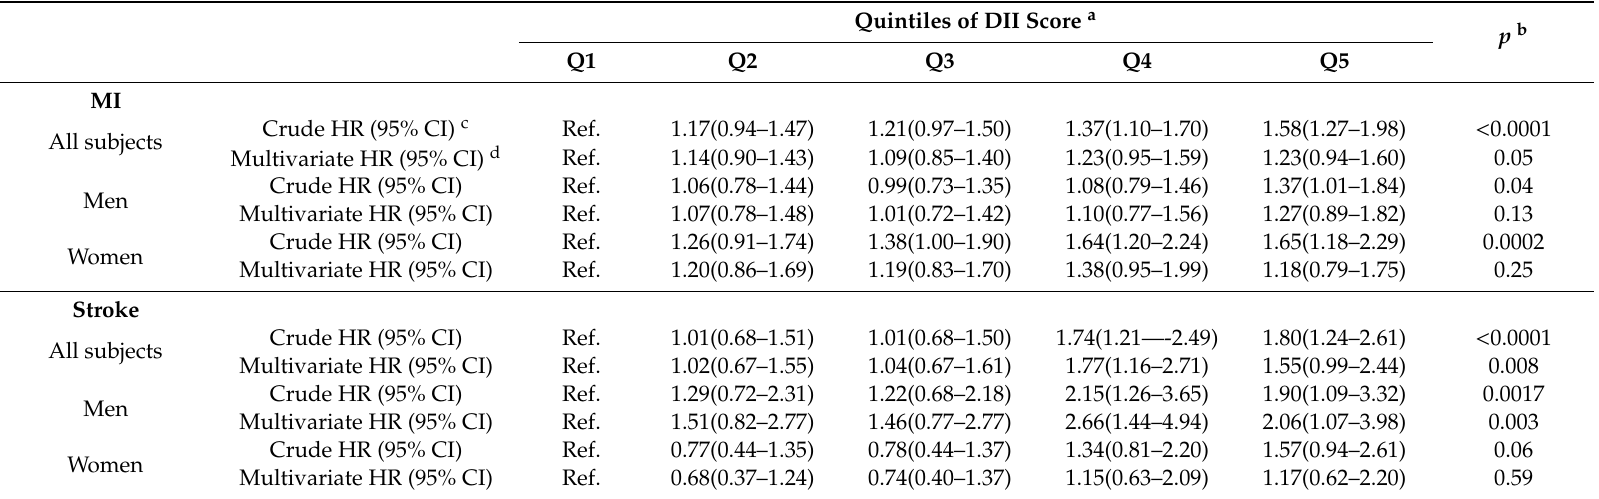
Table 3. Cox proportional hazard ratios (HRs) (95% Confidence Intervals (CIs) for myocardial infarction (MI) and stroke risk by quintiles of DII score for all participants in the KOGES_HEXA cohort,